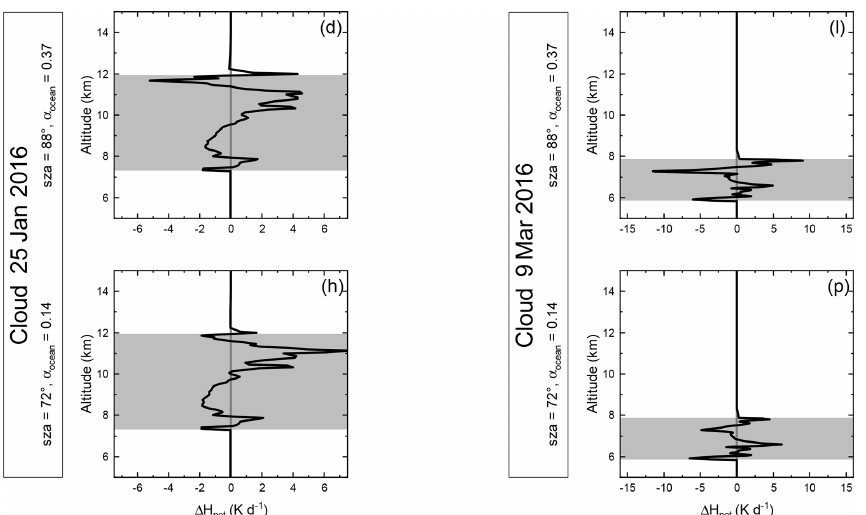
Figure 13. The same as Fig. 11d, h, l and p but for ice clouds with higher optical thicknesses as a result of multiplying the entire profile IWC( z ) by a factor of